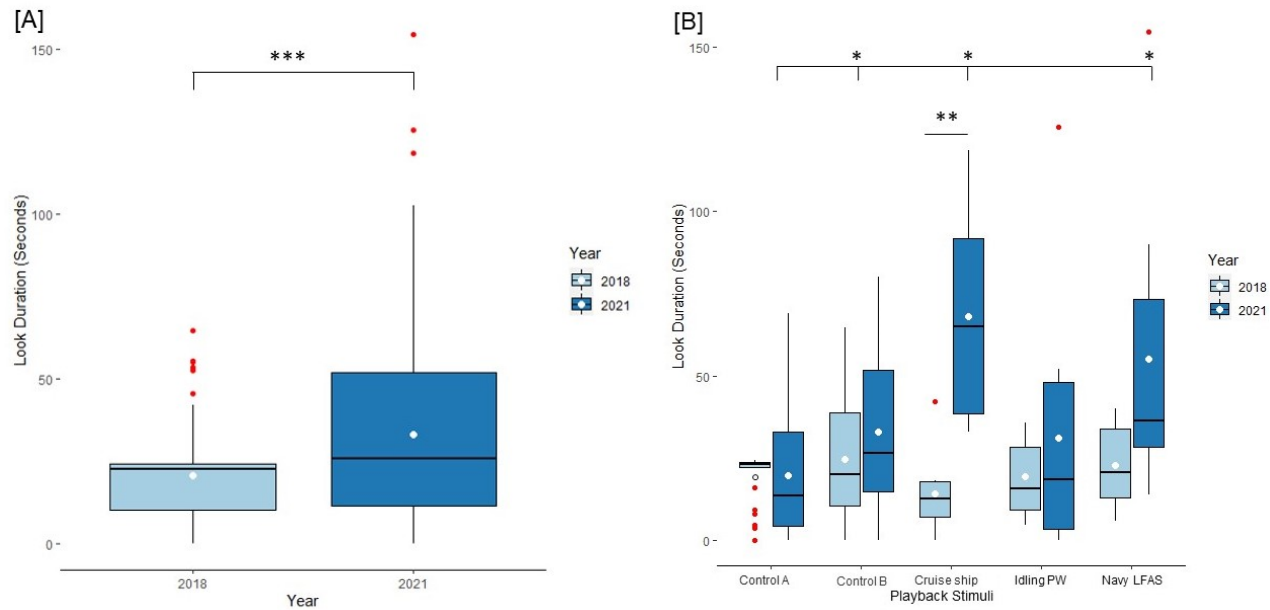
Figure 6. Look duration responses broken down by playback stimuli and year. ( A ) Boxplots rep- resenting the interquartile range of look responses (seconds) by year. Outlier points are included in red. The means of each group are represented by the white circles in each box. ( B ) Boxplots illustrating the interquartile range of look duration responses across playback files and year. The top line with an asterisk denotes significance across playbacks and the lower line without endcaps denotes significance for a pairwise comparison across years. The dot that indicates the mean for control A is outlined with a black line. * = p < 0.05, ** = p < 0.01, *** = p < 0.001. Idling PW = idling personal watercraft.